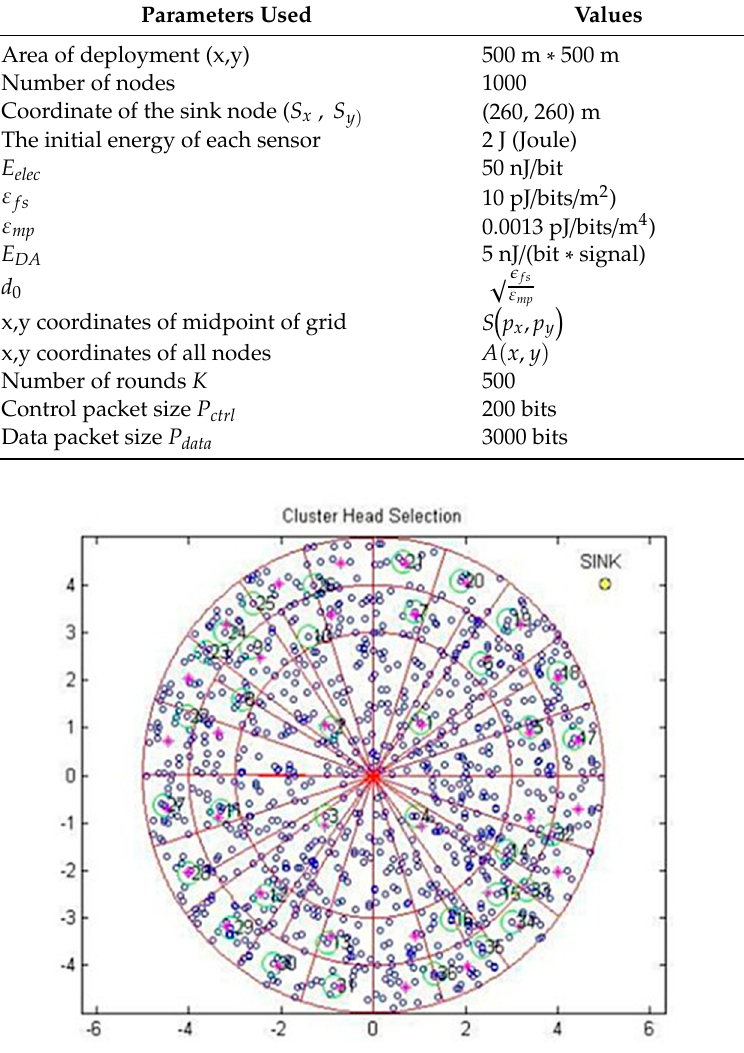
Figure 2. Node deployment and CH selection.